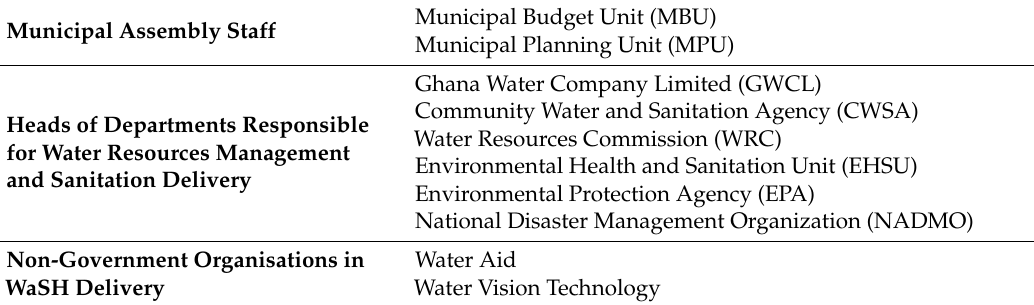
Table 1. Institutions selected for interviews, on the basis of their responsibilities for water management, disaster preparedness, and environmental management in the Bolgatanga Municipality. WaSH: water, sanitation and